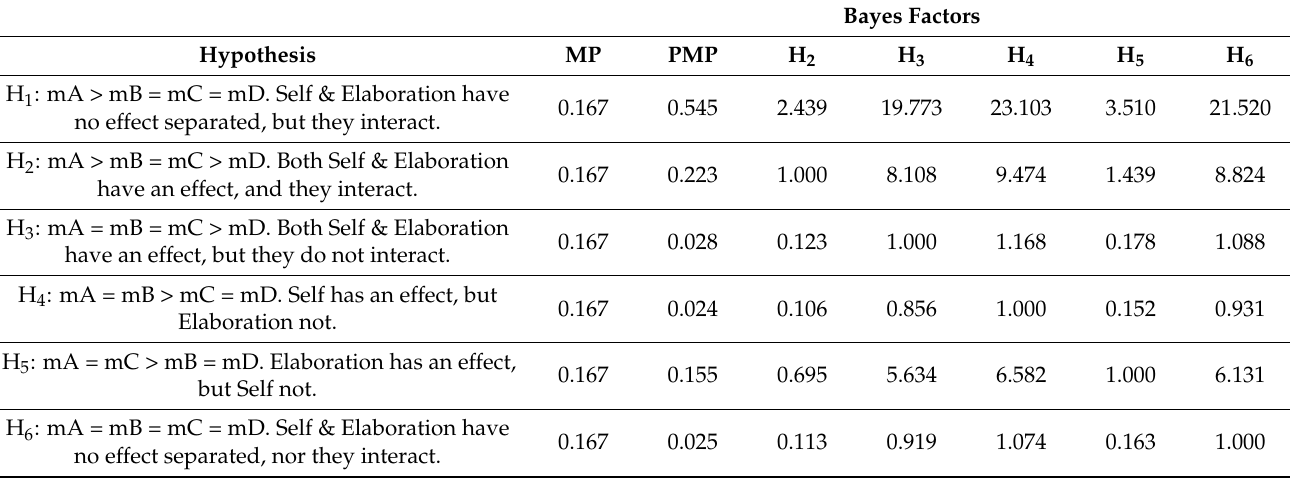
Table 3. Posterior model probabilities and Bayes factors matrix of the alternative hypotheses evaluated regarding the increase in pain tolerance. The Bayes factor matrix compares the hypothesis on the row against the hypothesis on the